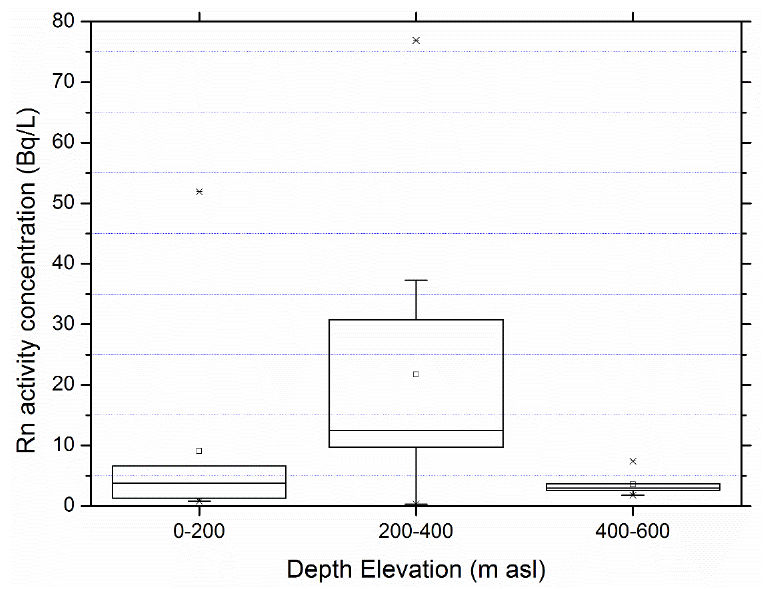
Figure 5. Box-and-whisker plot for the radon activity concentration values, grouped depending on concentration of radon and geographic distribution.